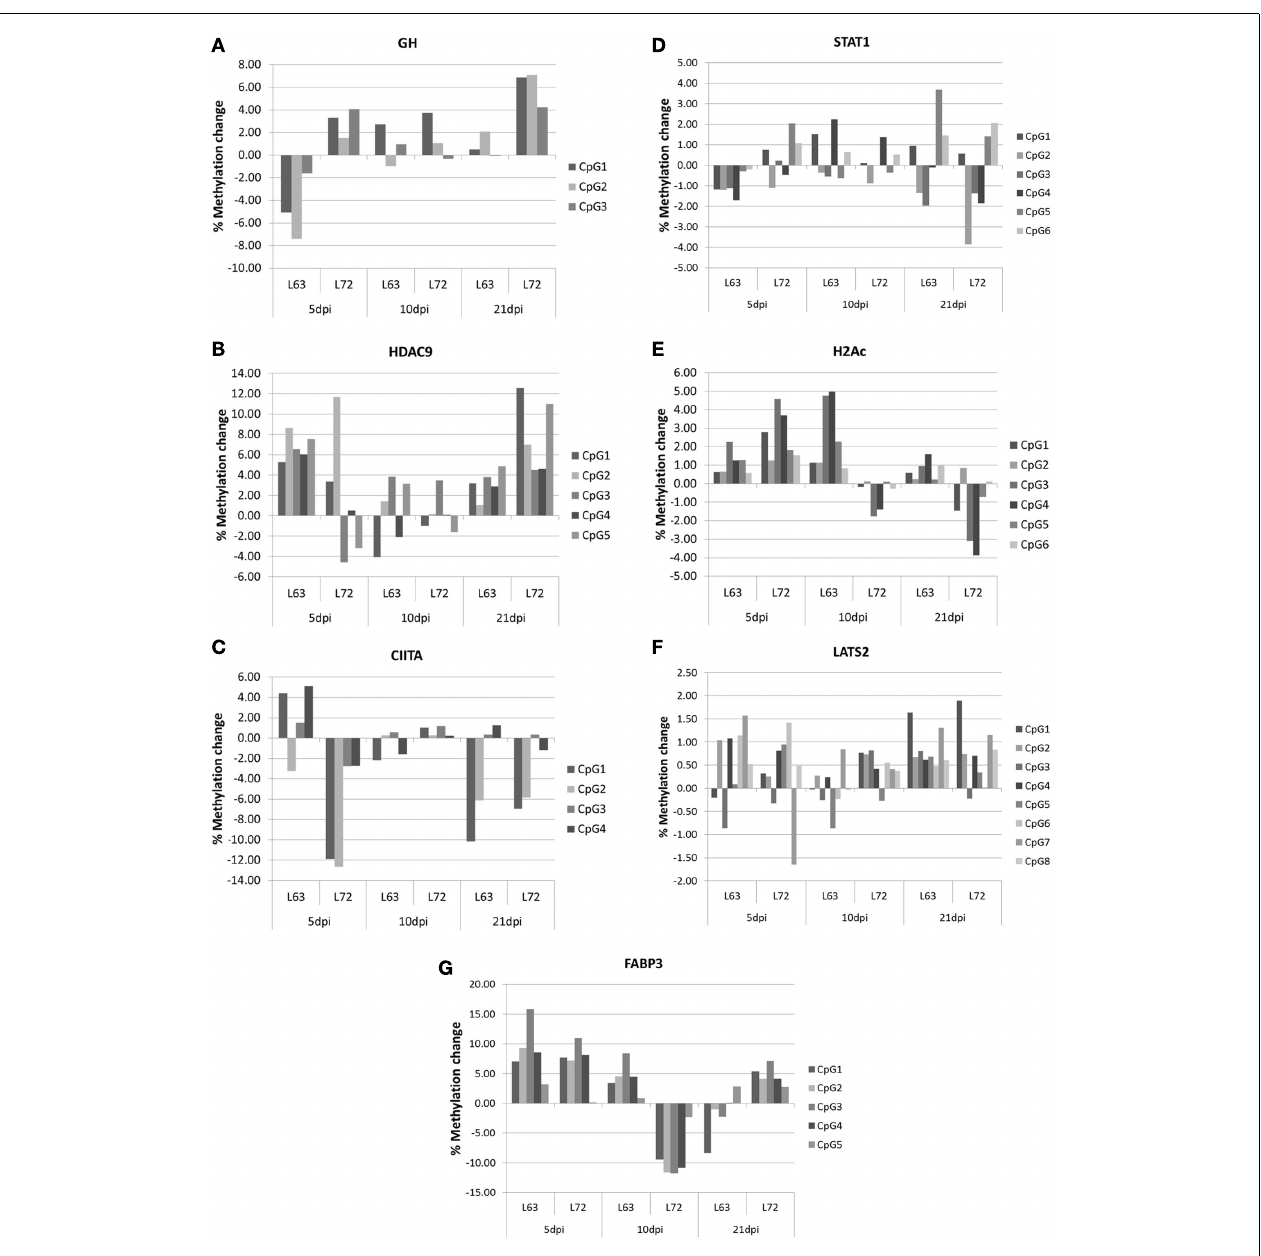
FIGUREA1 | Promoter methylation change during MDV life cycle in GH (A), HDAC9 (B), CIITA (C), STAT1 (D), H2Ac (E), LATS2 (F), and FABP3 (G) . The methylation change within lines was the methylation changed after MDV infection compared with the promoter methylation level before MDV infection. N = 4 for each